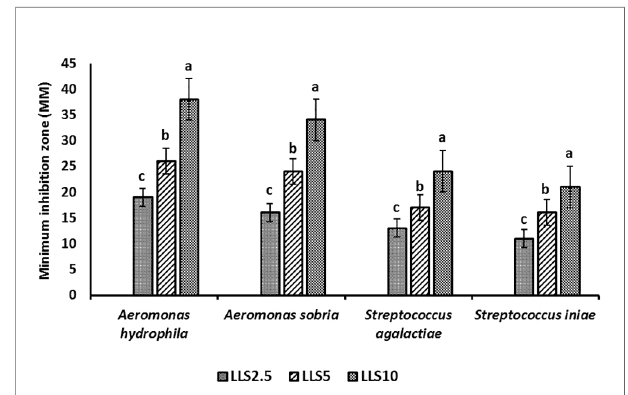
FIGURE 3 | Antibacterial activity (safe zone, mm) of L. siceraria ethanolic extract (LSEE) against 4 selected bacterial strains. Data were presented as mean ± SD. Different superscript letters indicate signi fi cantly different (ANOVA, P <